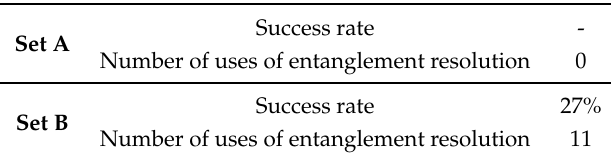
Table 8. Percentages of picking attempts where the entanglement resolution step was performed that resulted in a successful